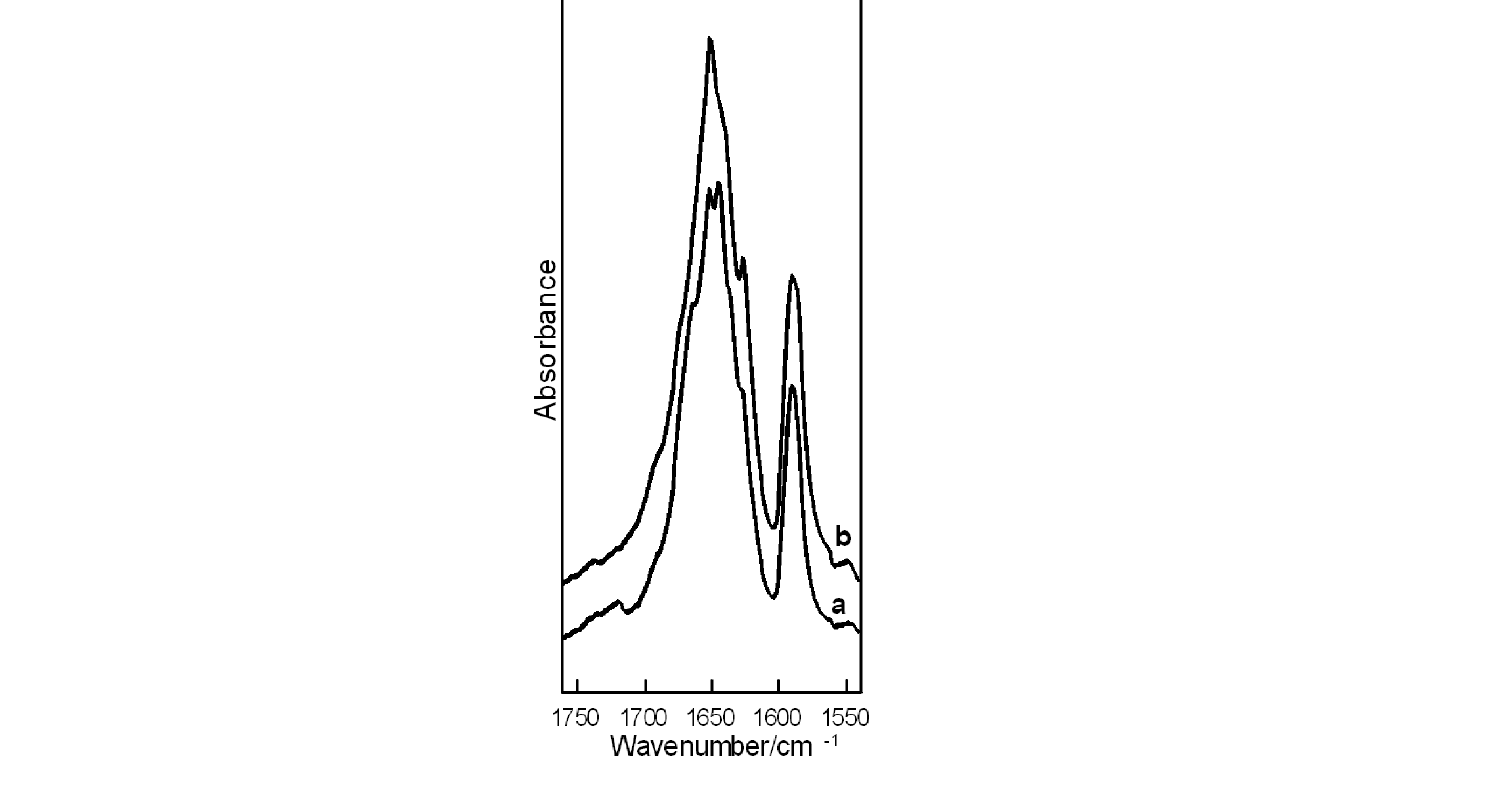
Fig. 8 The LNT IR spectrum of the (a) protiated and (b) deuterated analogue of K 3 (sac) 3 ¢ 2H 2 O (ca . 30 % deuterium content) in the region where ¸ ( CO ) mode is